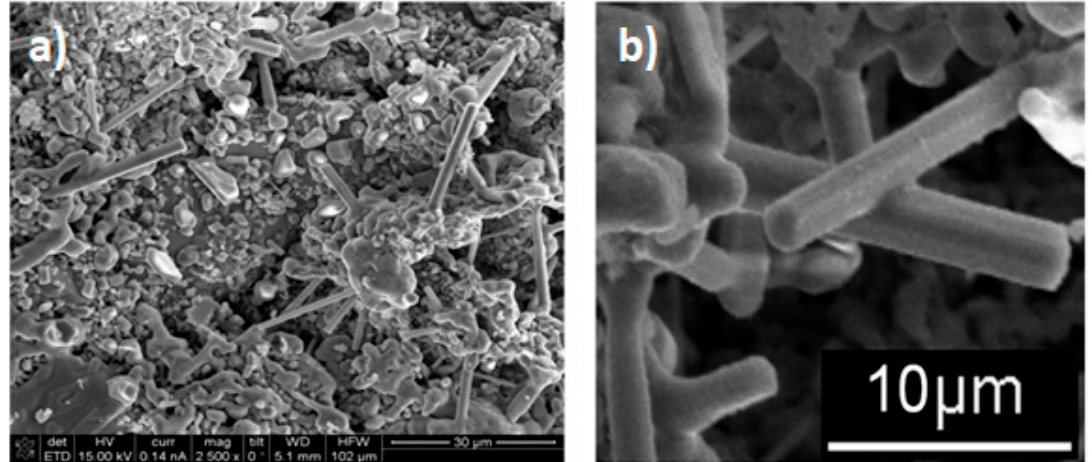
Figure 4. ( a ) Sample sintered at 900 °C for one hour and ( b ) formation of intermetallic microrod of the AlTiFe system.